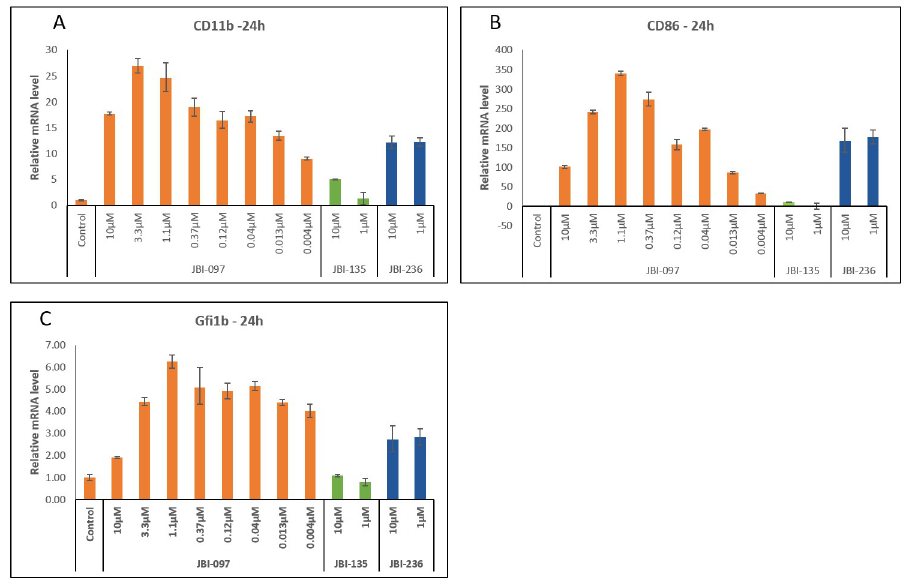
Fig 3. JBI-097 effect on the modulation of differentiation markers in HEL 92.1.7 cells. (3A) Effect of JBI-097 on CD11b modulation in HEL 92.1.7 Cells. Cells were treated with 8 concentrations of JBI-097, 10 and 1 μ M of JBI-135 (Ricolinostat) and JBI-236 (Iadademstat) for 24h and the mRNA level of CD11b was estimated by RT-qPCR. Error bars indicate mean ± S.E, ( 3B) Effect of JBI-097 on CD86 modulation in HEL 92.1.7 Cells. Cells were treated with 8 point CRC of JBI-097, 10 and 1 μ M of JBI-135 (Ricolinostat) and JBI-236 (Iadademstat) for 24h and the mRNA level of CD86 was estimated by RT-q PCR. Error bars indicate mean ± S.E, ( 3C) Effect of JBI-097 on Gfi1b modulation in HEL 92.1.7 Cells. Cells were treated with 8 point CRC of JBI-097, 10 and 1 μ M of JBI-135 (Ricolinostat) and JBI-236 (Iadademstat) for 24h and the mRNA level of Gfi1b was estimated by RT-q PCR. Error bars indicate mean ± S.E.